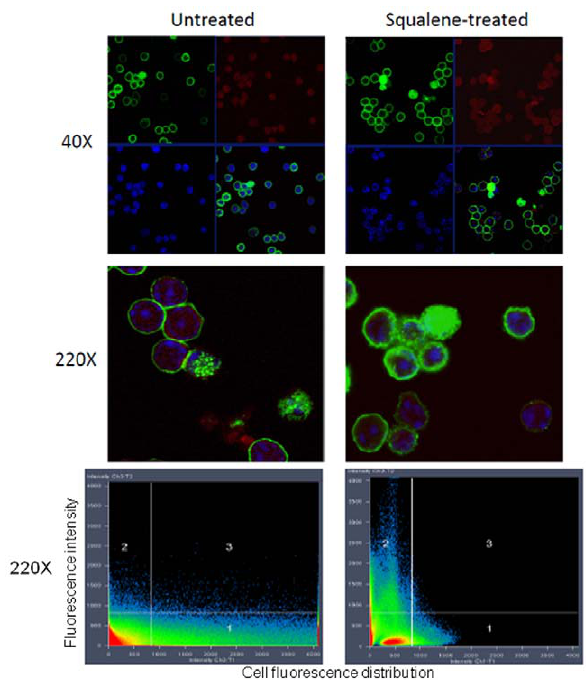
Figure 2. Squalene induced accumulation of membrane cholesterol in resting CD4 T-cells alters the partitioning of lipid rafts. Negatively-sorted CD4 + splenocytes were isolated from the spleen of untreated or squalene treated (single 180 m g dose/mouse) F1 mice 7 days post-injection. Cells were co-stained with CD4-PE, CTB-FITC and DAPI and analyzed by CLSM. Upper panels, quadrants indicating single-color stained cells at X40 magnification from untreated ( left column ) and squalene treated F1 mouse ( right column ): upper left quadrant, CTB-FITC staining (green); upper right quadrant, CD4-PE stain (red); lower left quadrant, DAPI staining of nuclei (blue), and lower right quadrant, merged channels for CTB-FITC, CD4-PE and DAPI staining. Middle panels , merged CTB-FITC, CD4-PE and DAPI staining of clusters of splenocytes from untreated and squalene treated F1 mouse at X220 magnification. Bottom panels, color intensity quantification for cell clusters shown in the middle panels using the using the ZEISS ZEN 2009 analysis software. Of note, the amount of GM1 moiety revealed by CTB- FITC (green) in merged channel 2 is significantly higher for the CD4 T- cells from squalene treated mouse than that of the untreated mouse. Shown is one of three mice analyzed in each group.